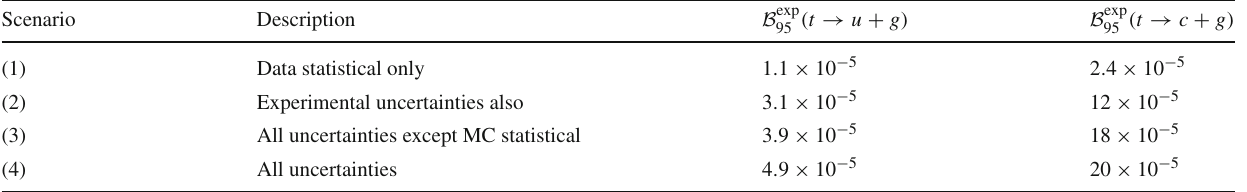
statistical uncertainties, (2) include the experimental systematic uncer- tainties in addition, (3) include all systematic uncertainties except for the MC statistical uncertainties and (4) include all